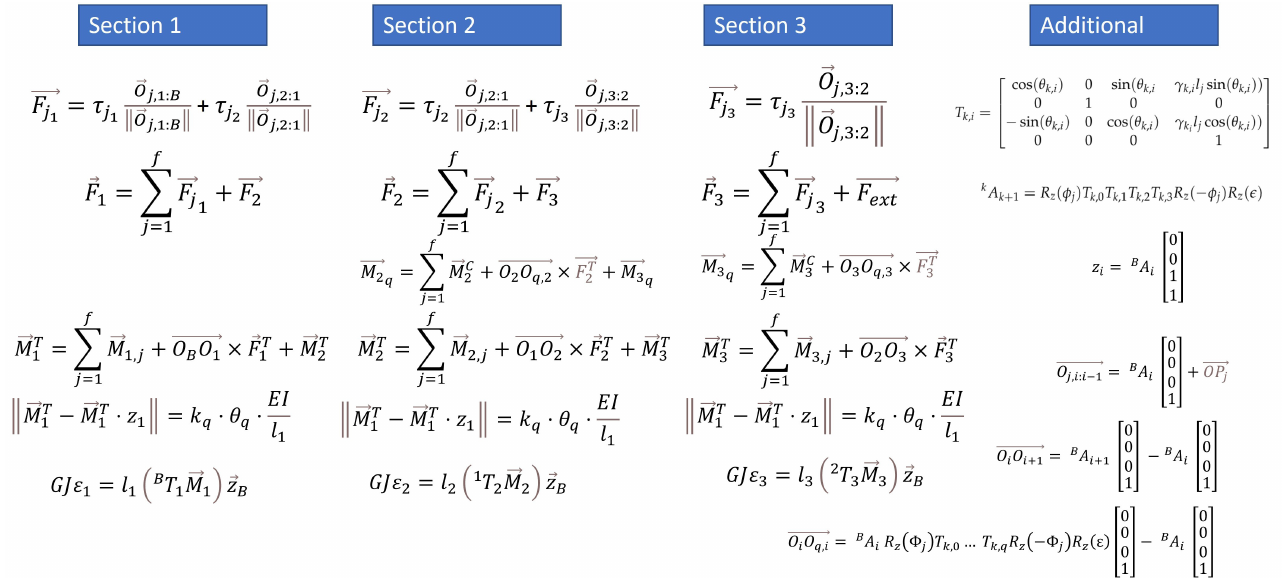
Figure 27. Equations applied to Ruan